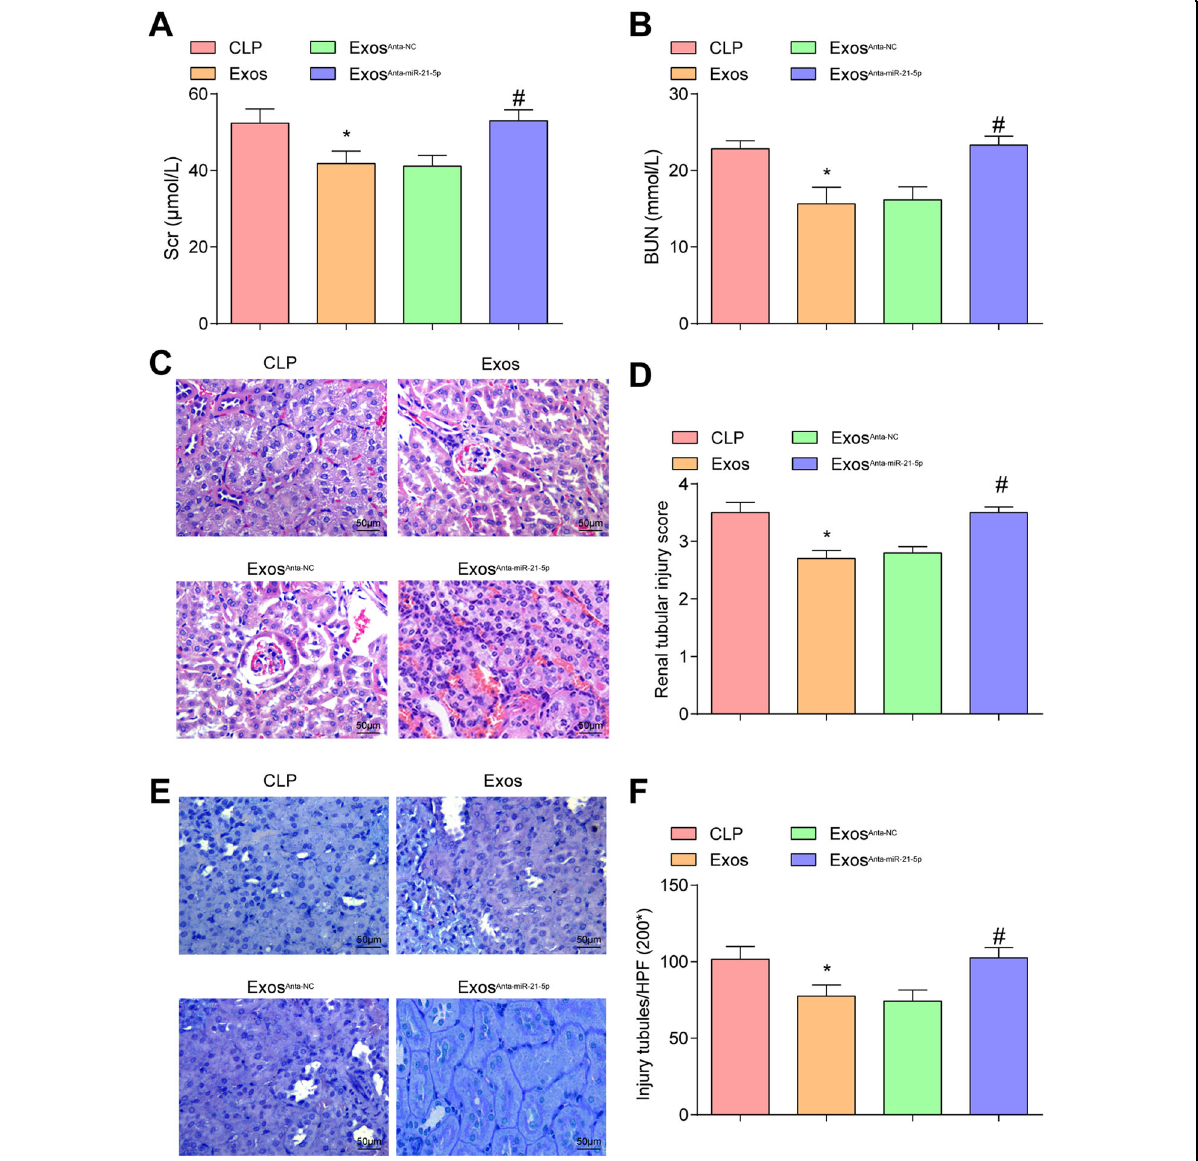
Fig. 5 Effects of EPCs-Exos on renal function and pathological changes in the kidney of CLP rats. A Comparison of Scr concentration in CLP rats. B Comparison of BUN concentration in CLP rats. C HE staining of rat renal tissues of CLP rats (scale bar = 50 μ m). D Comparison of renal tubular injury scores. E PAS staining of rat renal tissues of CLP rats (scale bar = 50 μ m). F Comparison of the number of renal tubular injuries of CLP rats. n = 10. * P < 0.05 vs. the CLP group. # P < 0.05 vs. the Exos Anta-NC group. Measurement data were depicted as mean ± standard